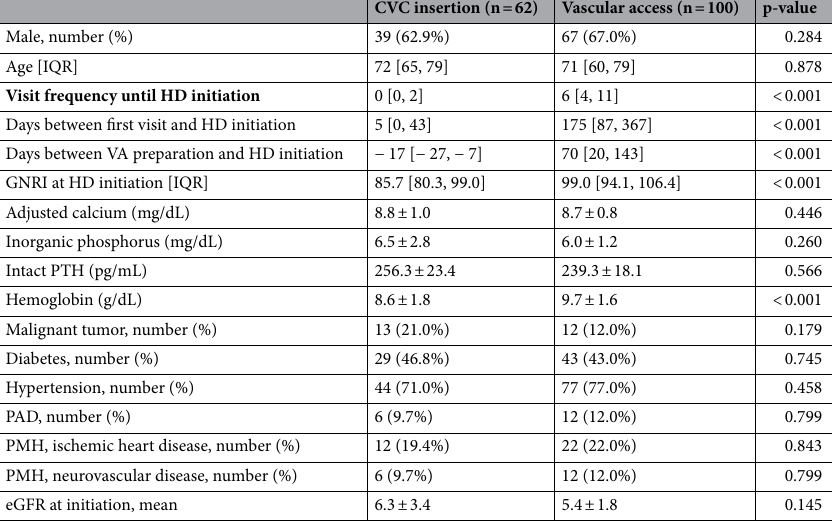
Table 1. Clinical characteristics of patients undergoing HD. CVC, central venous catheter; eGFR, estimated glomerular filtration rate; GNRI, geriatric nutritional risk index; HD, hemodialysis; IQR, interquartile range; PAD, peripheral artery disease; PMH, past medical history; PTH, parathyroid hormone; RRT, renal replacement therapy; VA, vascular